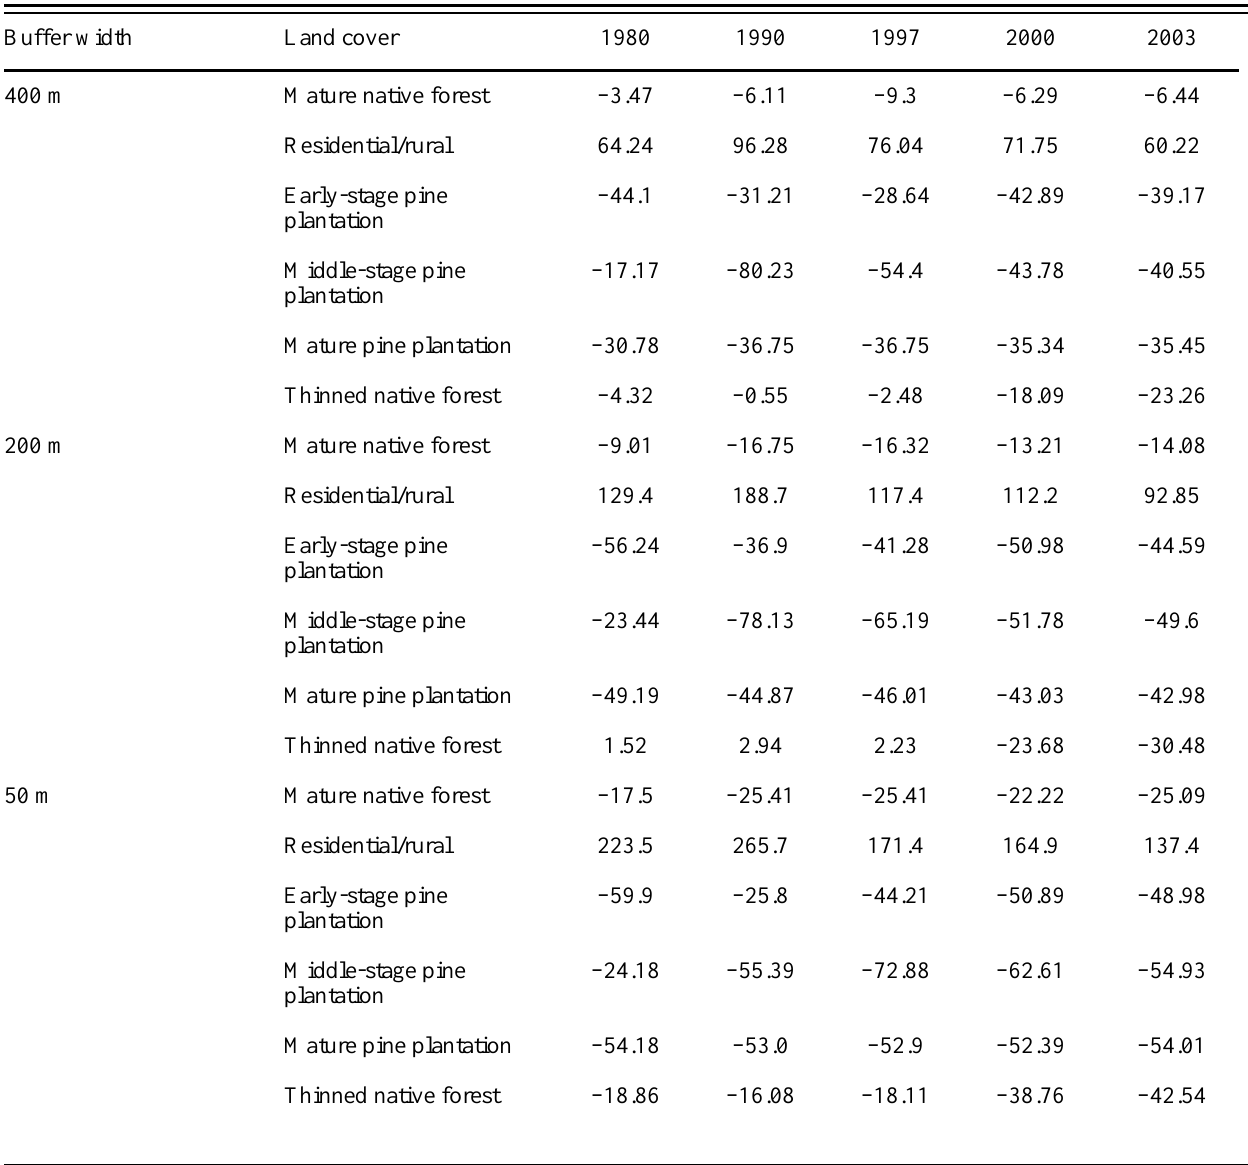
Table 4. Percentage over- (positive values) or underrepresentation (negative values) of land cover in roadside buffers of three widths along roads on the southern Cumberland Plateau, Tennessee, compared to the land cover of the surrounding region for fine-resolution land cover